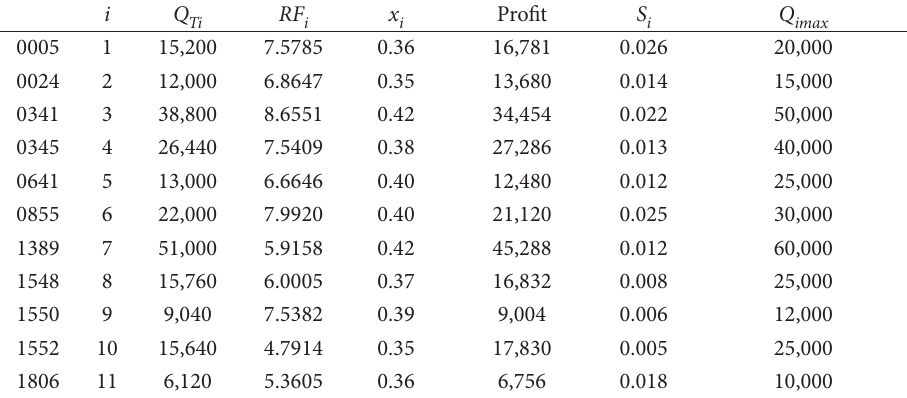
Table 4. Past data of vendors at time period t-